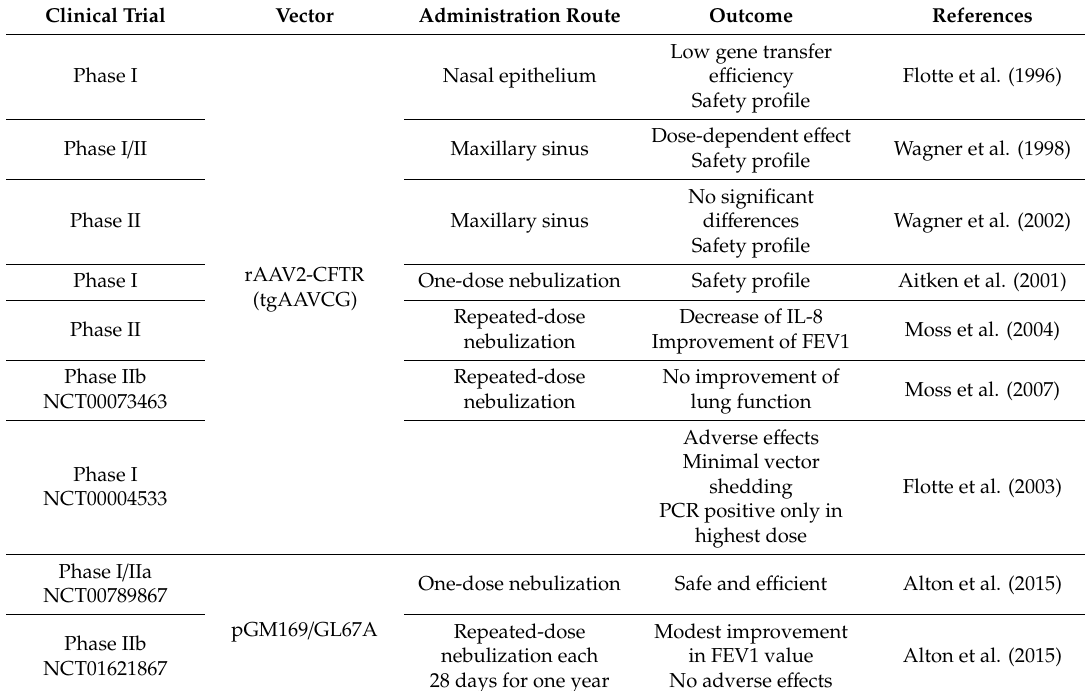
Table 5. Summary of clinical trials performed in CF with tgAAVCG viral vector and pGM169 / GL67A non-viral vector. FEV1: Forced Expiratory Volume in the first second, IL: interleukin. Clinical Trial Vector Administration Route